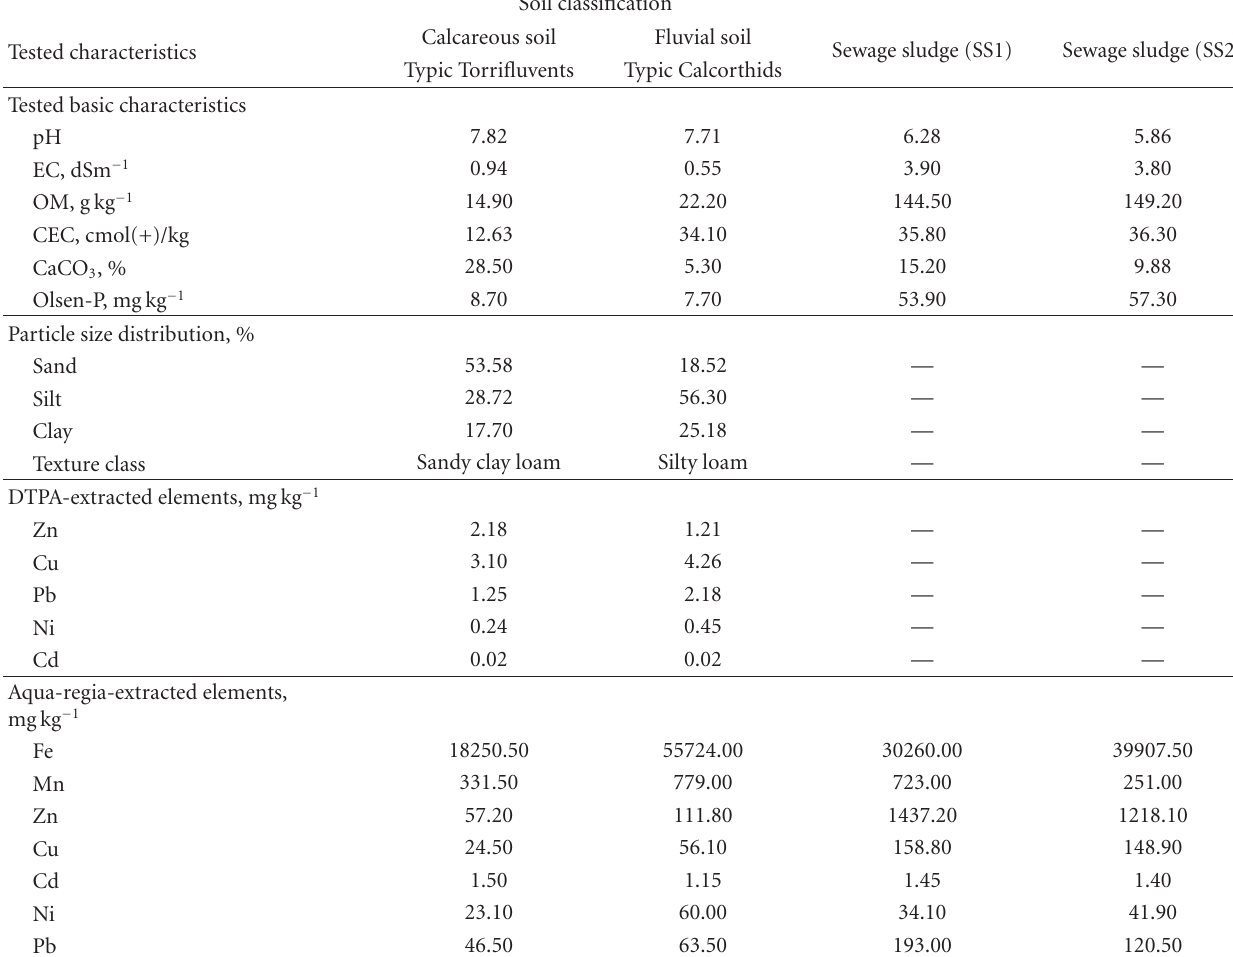
Table 2: Selected characteristics and metal concentrations in the studied soils and sewage